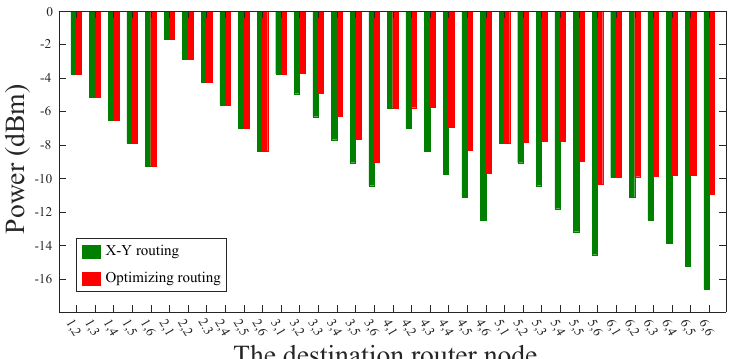
Figure 9. Signal power comparison between traditional routing algorithm and our optimization algorithm in a 6 × 6 mesh-based ONoC.